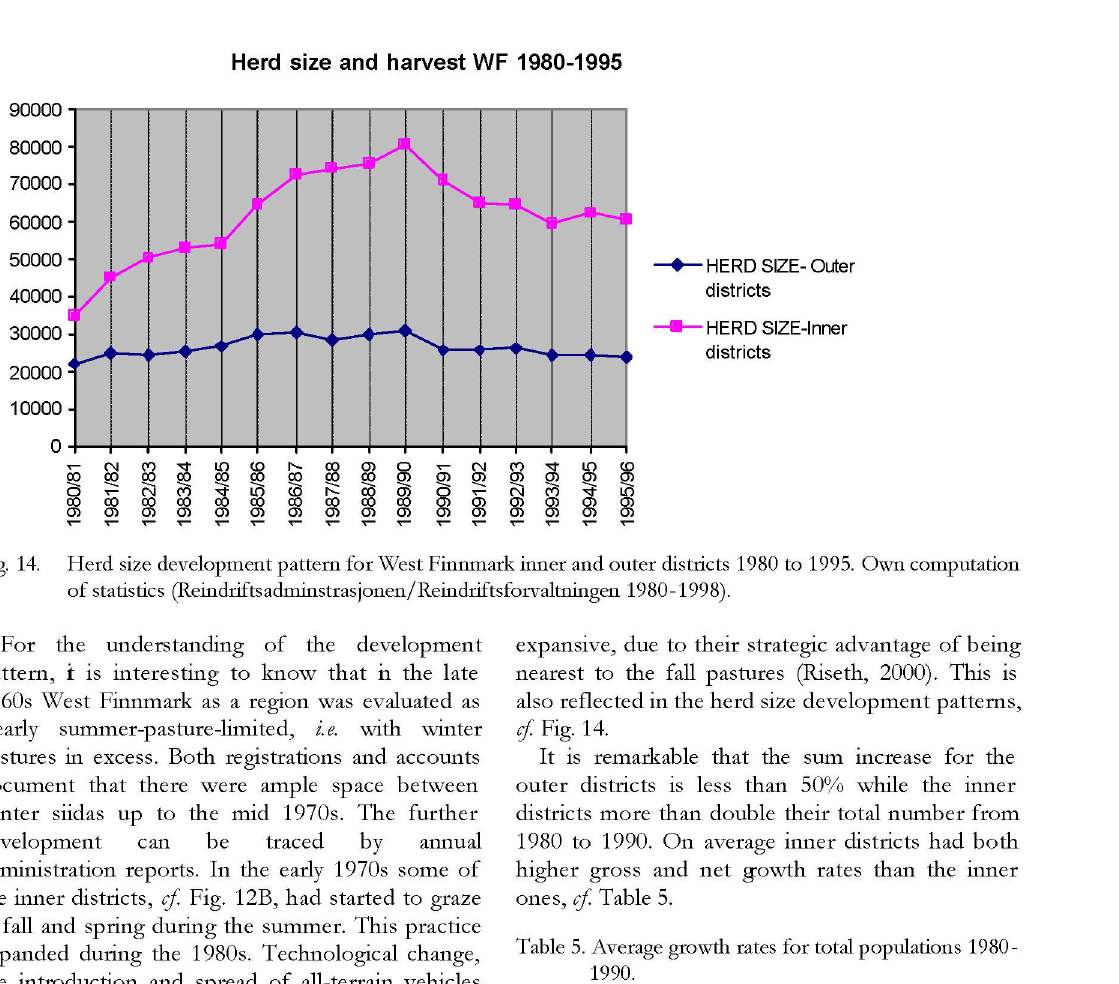
Table 5. Average growth rates for total populations